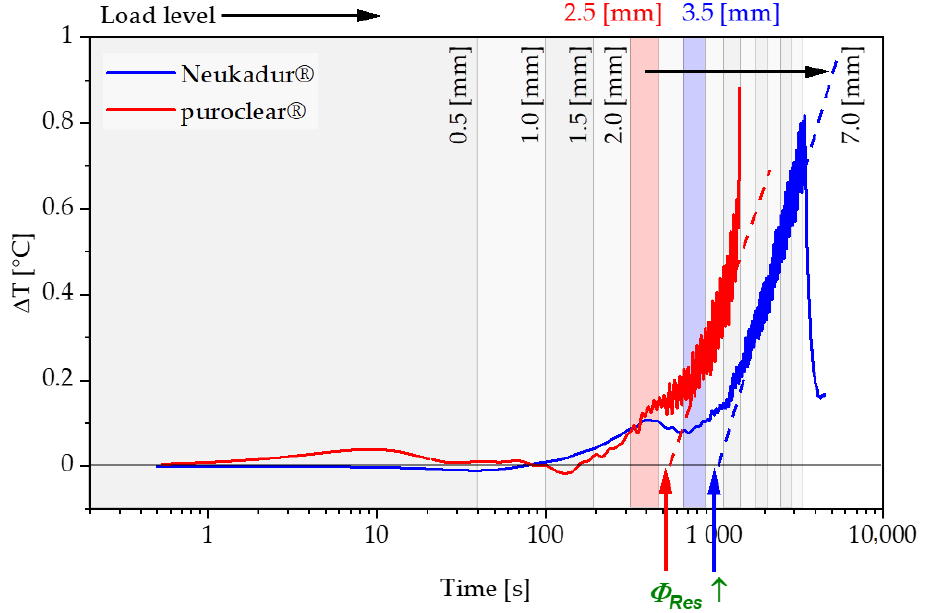
Figure 13. Sample heating during the test procedure for Neukadur ® and puroclear ® for a strain rate of 0.018 s − 1 under tensile load.